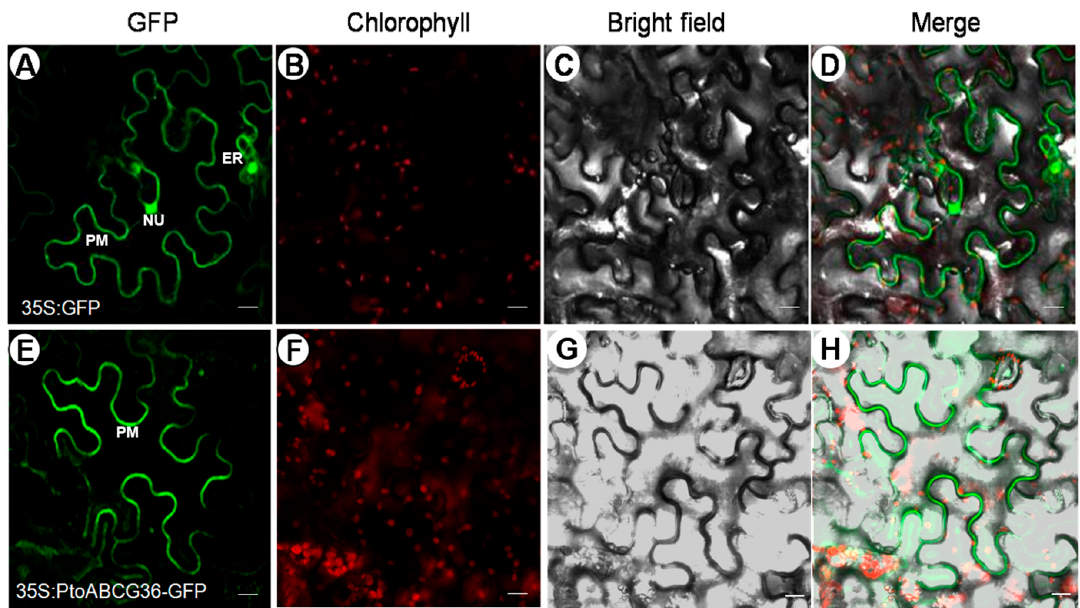
Figure 3. Subcellular localization of PtoABCG36 in epidermal cells of Nicotiana benthamiana . The fluorescence of green fluorescent protein (GFP) or PtoABCG36-GFP signal in tobacco leaf cell ( A , E ). Chlorophyll autofluorescence ( B , F ). Bright field ( C , G ). The overlap images of bright field and fluorescence images ( D , H ). Scale bars = 20 µ m. NU, nucleus; PM, plasma membrane; ER, endoplasmic reticulum.